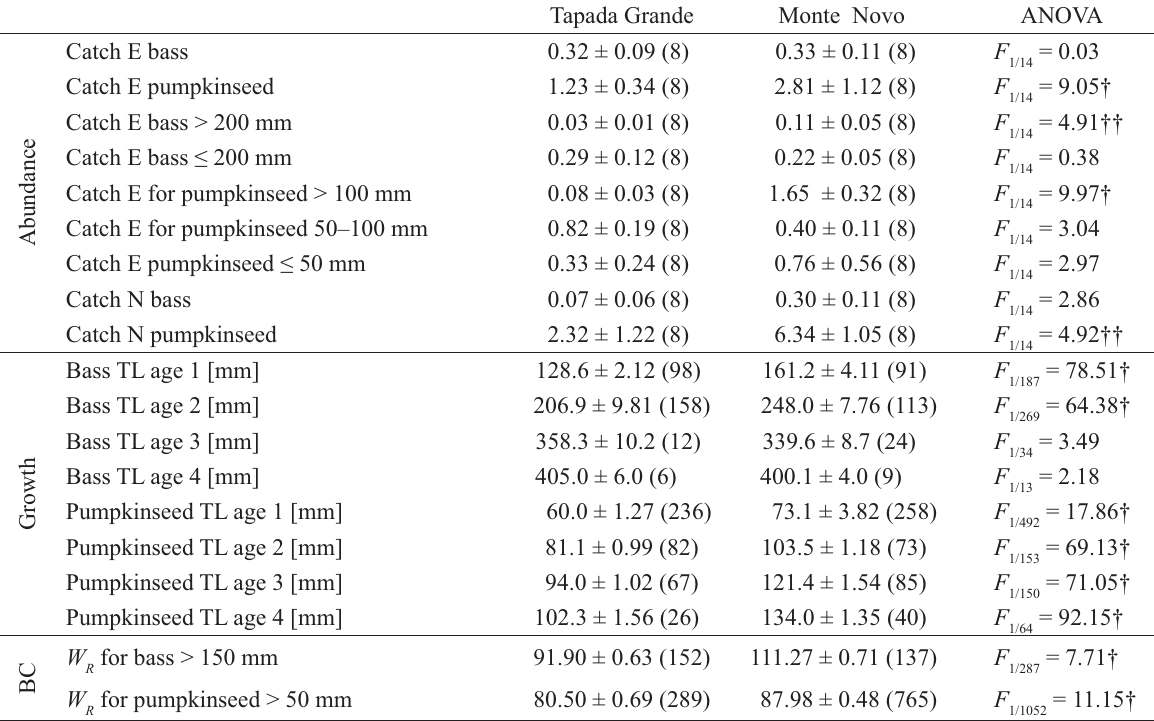
Characteristics of the largemouth black bass, Micropterus salmoides, and the pumpkinseed, Lepomis gibbosus , populations sampled in Monte Novo and Tapada Grande reservoirs, Iberian